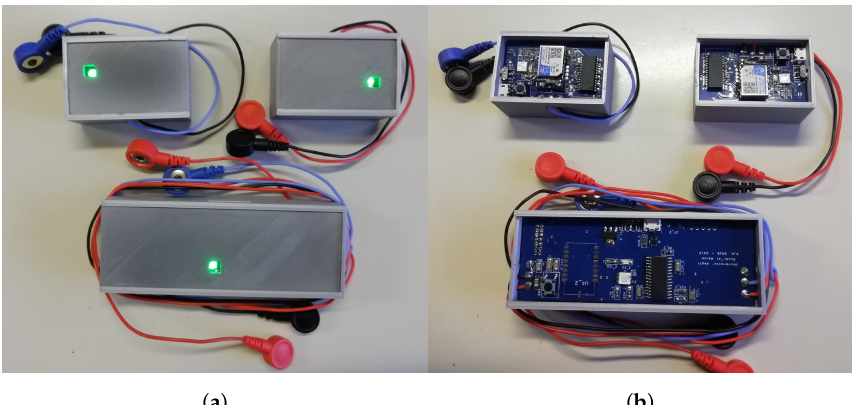
Figure 2. ( a ) Enclosures of SPR boxes and ECG box, and ( b ) Printed Circuit Boards of the developed